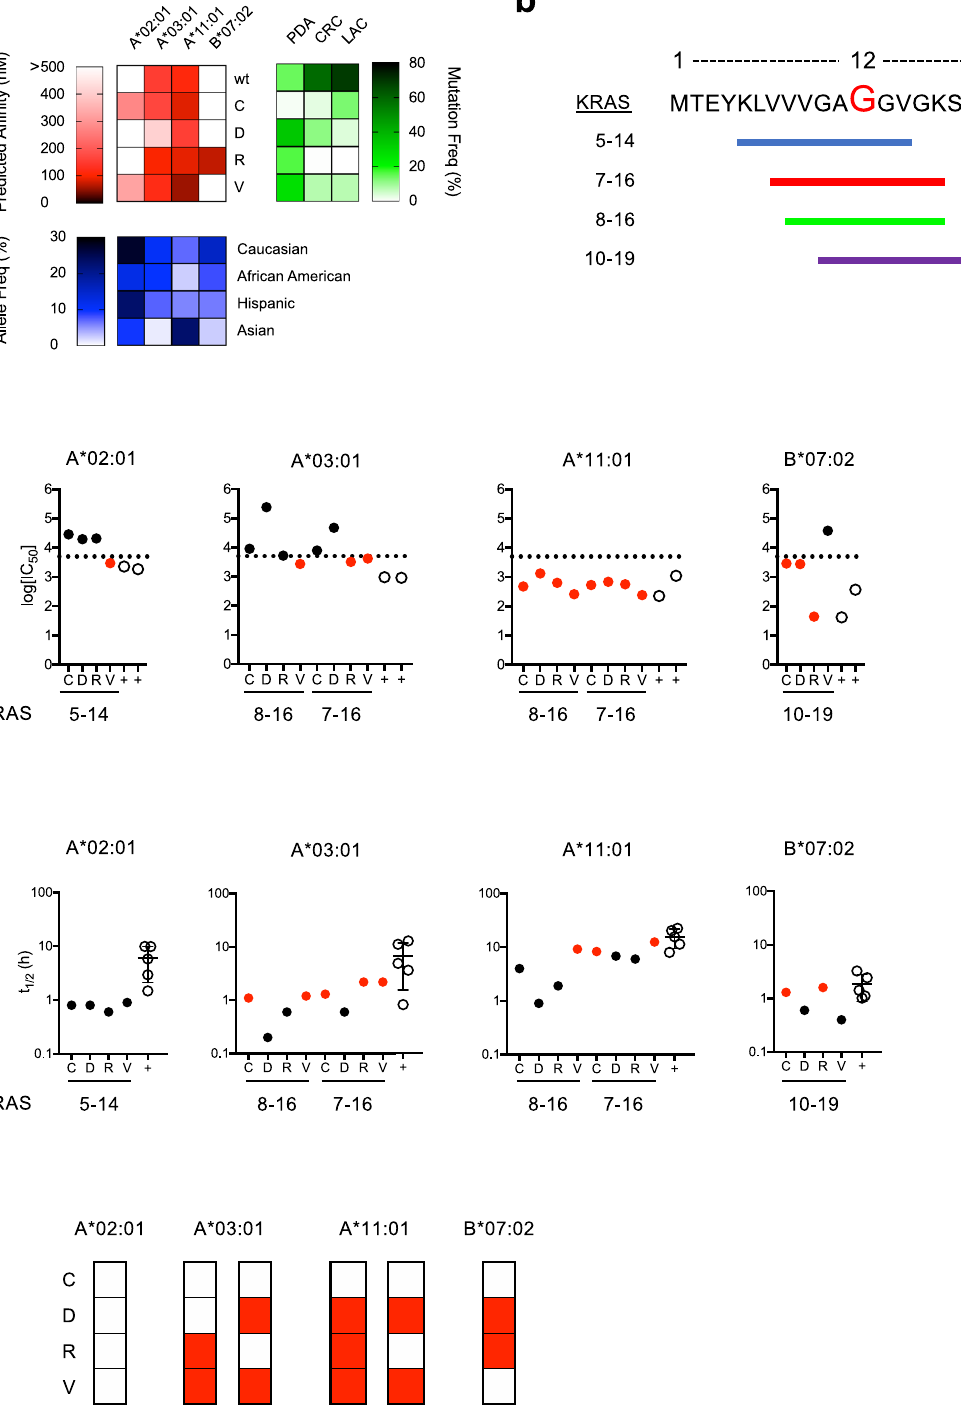
I binding af fi nity (log 10 [IC 50 ] = 3.469 nM) (Fig. 1c). However, all p- HLA-A * 02:01 class I complexes exhibited short half-lives ( t 1/2 < 1 h) compared to control peptides ( t 1/2 1.3 – 10.1 h, Fig. 1d). For HLA- A * 03:01 epitopes, peptides 7-16R, 8-16V, and 7-16V exhibited strong binding af fi nity (log 10 [IC 50 ] ≤ 3.589 nM) (Fig. 1c) and formed p-HLA complexes with equivalent stability to positive controls ( t 1/2 > 1 h). All 9-mer (8-16C-V) and 10-mer (7-16C-V) peptides bound with strong af fi nity to HLA-A * 11:01 (log 10 [IC 50 ] ≤ 3.121 nM) (Fig. 1c), and